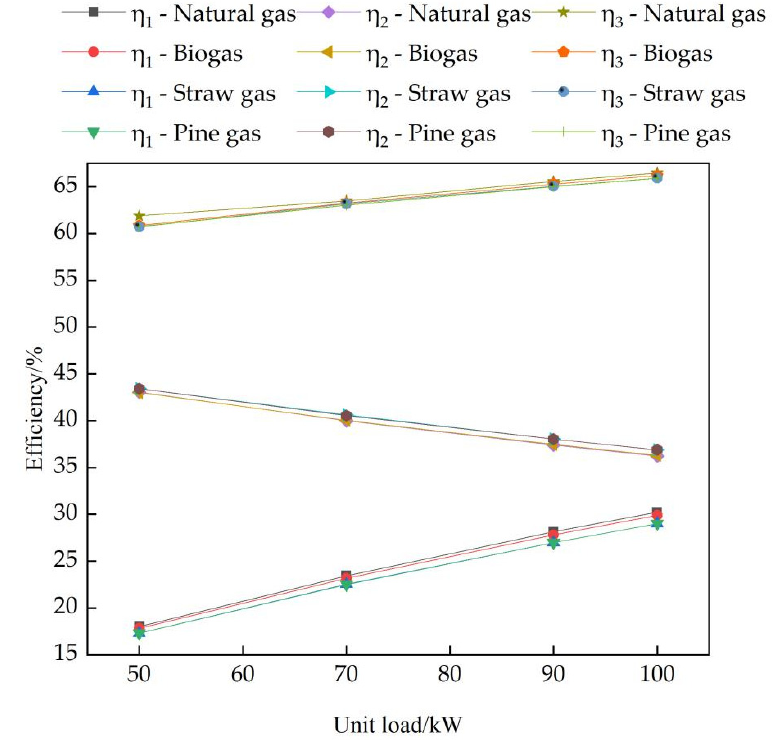
Figure 5. Partial load operation efficiency chart of recuperative cycle.